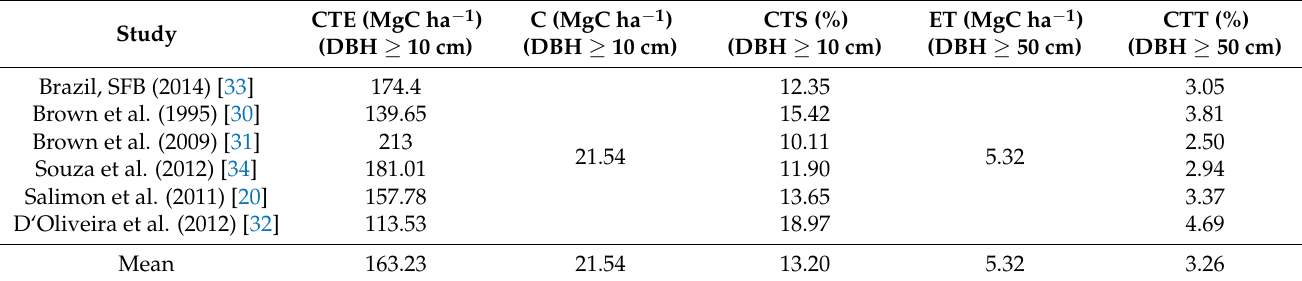
Table 6. Carbon stock for the forest, including trees of all species in the study area extrapolated from the literature, and for the commercial boles of harvested trees that are removed from the management